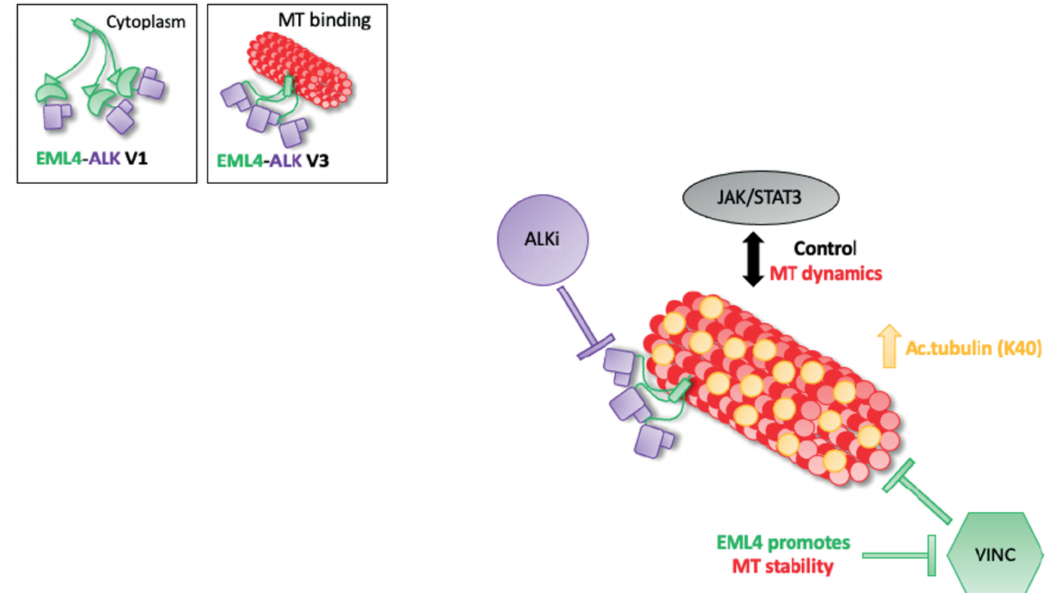
Figure 6. Model summarising the relationship between ALK signalling and MT dynamics in EML4-ALK V3. Schematic model showing the proposed drug resistance mechanism of EML4-ALK V3. EML4-ALK variants, the protein exists as a trimer via the dynamic